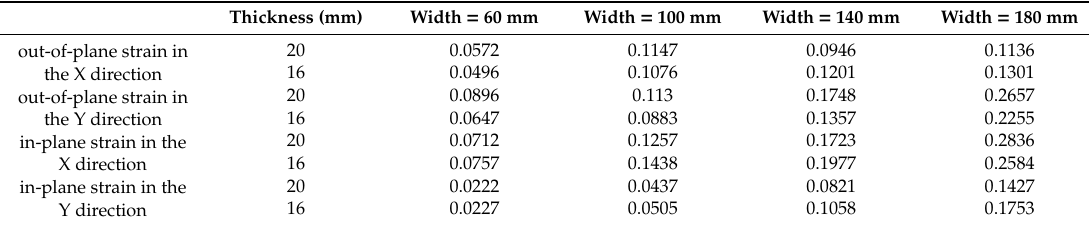
Table 5. Maximum relative variation.